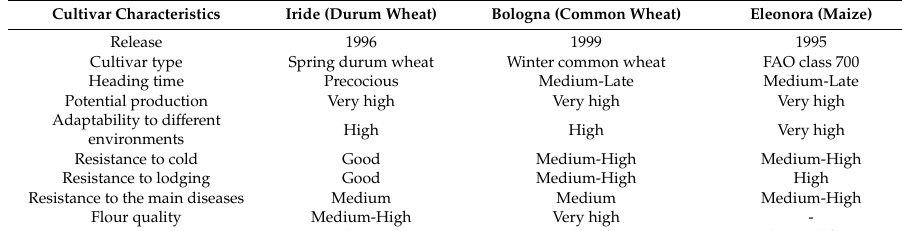
Table 2. Main characteristics of the crop varieties from [87–89].